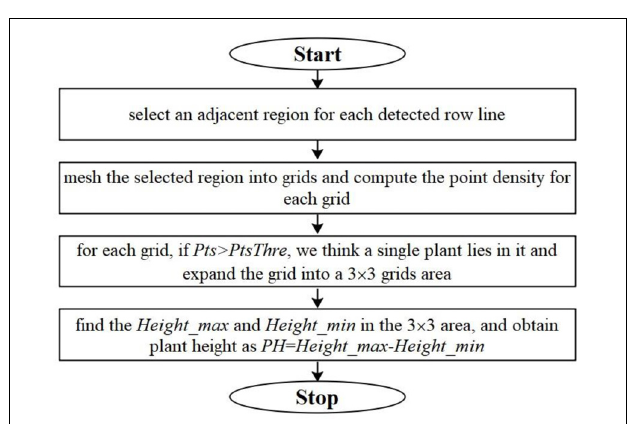
FIGURE 10 | Flowchart for plant height